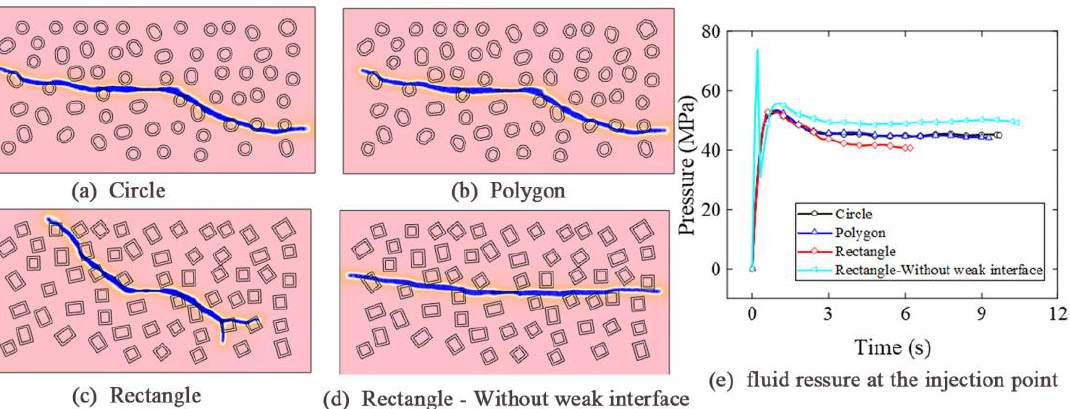
Figure 13. Fracture propagation and fluid pressure at the injection point in case of gravels with different roundness or without weak interfaces.